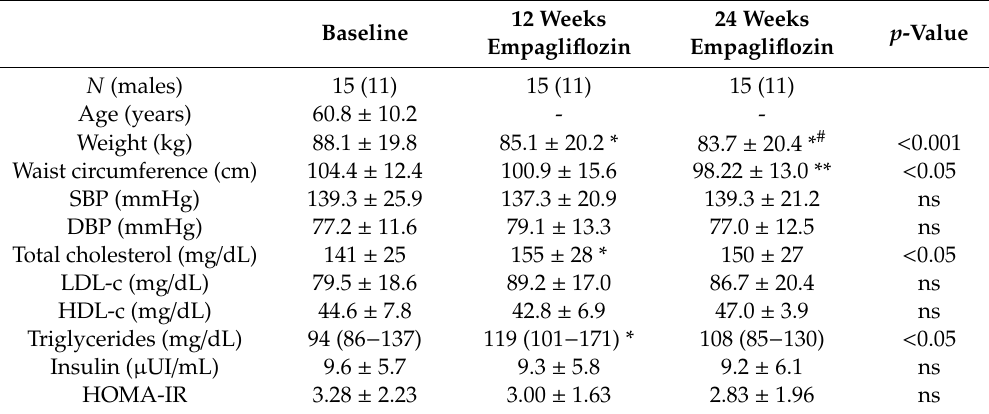
Table 1. Anthropometric parameters of the study population at baseline, 12 weeks and at the end of 24-week follow-up.